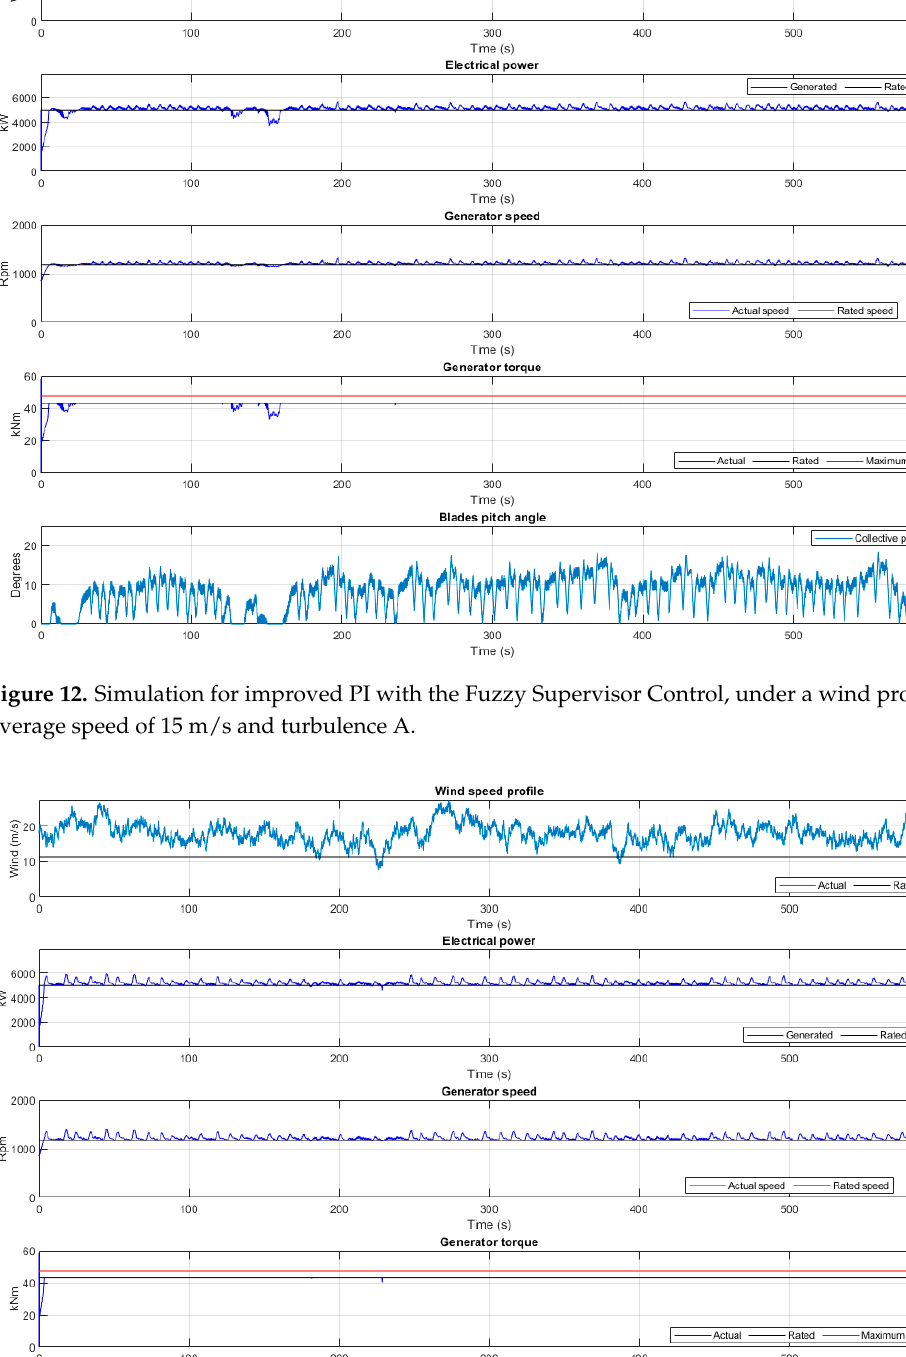
Figure 11. Simulation for improved PI with the Fuzzy Supervisor Control, under a wind profile of average speed of 13 m/s and turbulence A.